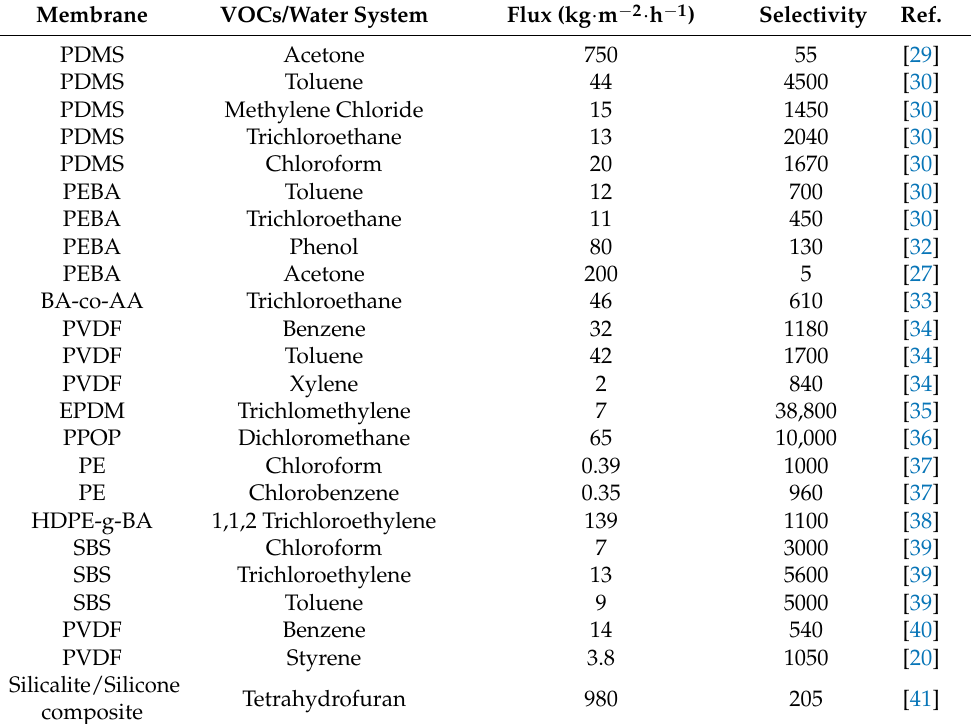
Table 1. Some membrane/VOC pervaporation binary/water systems and results of the total flux and selectivity obtained.